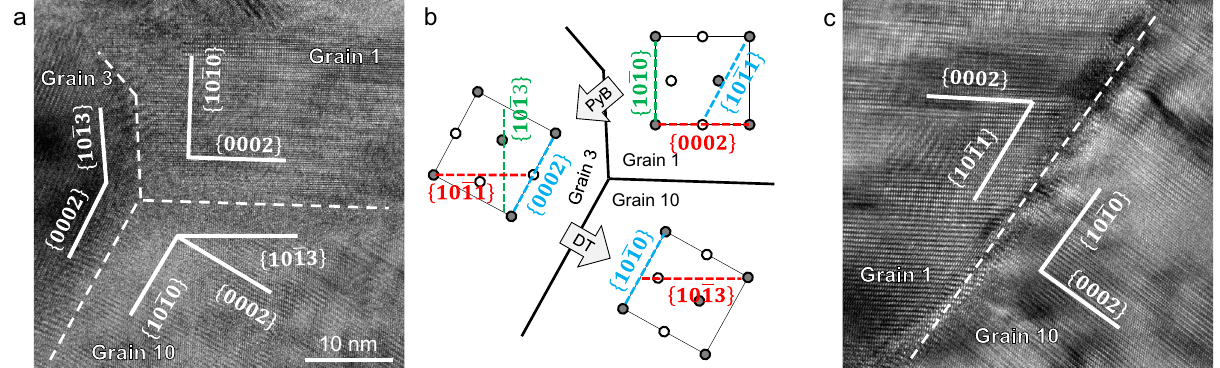
-- Fig. 7 Activation of f 10 12 g twinning following Py-B transformation. a A triple junction of the grain boundaries between grains 1, 3, and 10. This junction is composed of f 10 (cid:1) 10 g grain 1 = f 10 (cid:1) 13 g grain 3 interface, f 0002 g grain 3 = f 10 (cid:1) 10 g grain 10 interface (basal/prismatic interface) and f 0002 g grain 1 = f 10 (cid:1) 13 g grain 10 interface. b A possible pathway of the formation of grains 3 and 10 from grain 1. c A f 10 (cid:1) 11 g grain 1 = f 10 (cid:1) 10 g grain 10 interface between grain 1 and 10, corroborating the pathways in b . Zone axis, (cid:2)h 2 (cid:1) 1 (cid:1) 10 i .